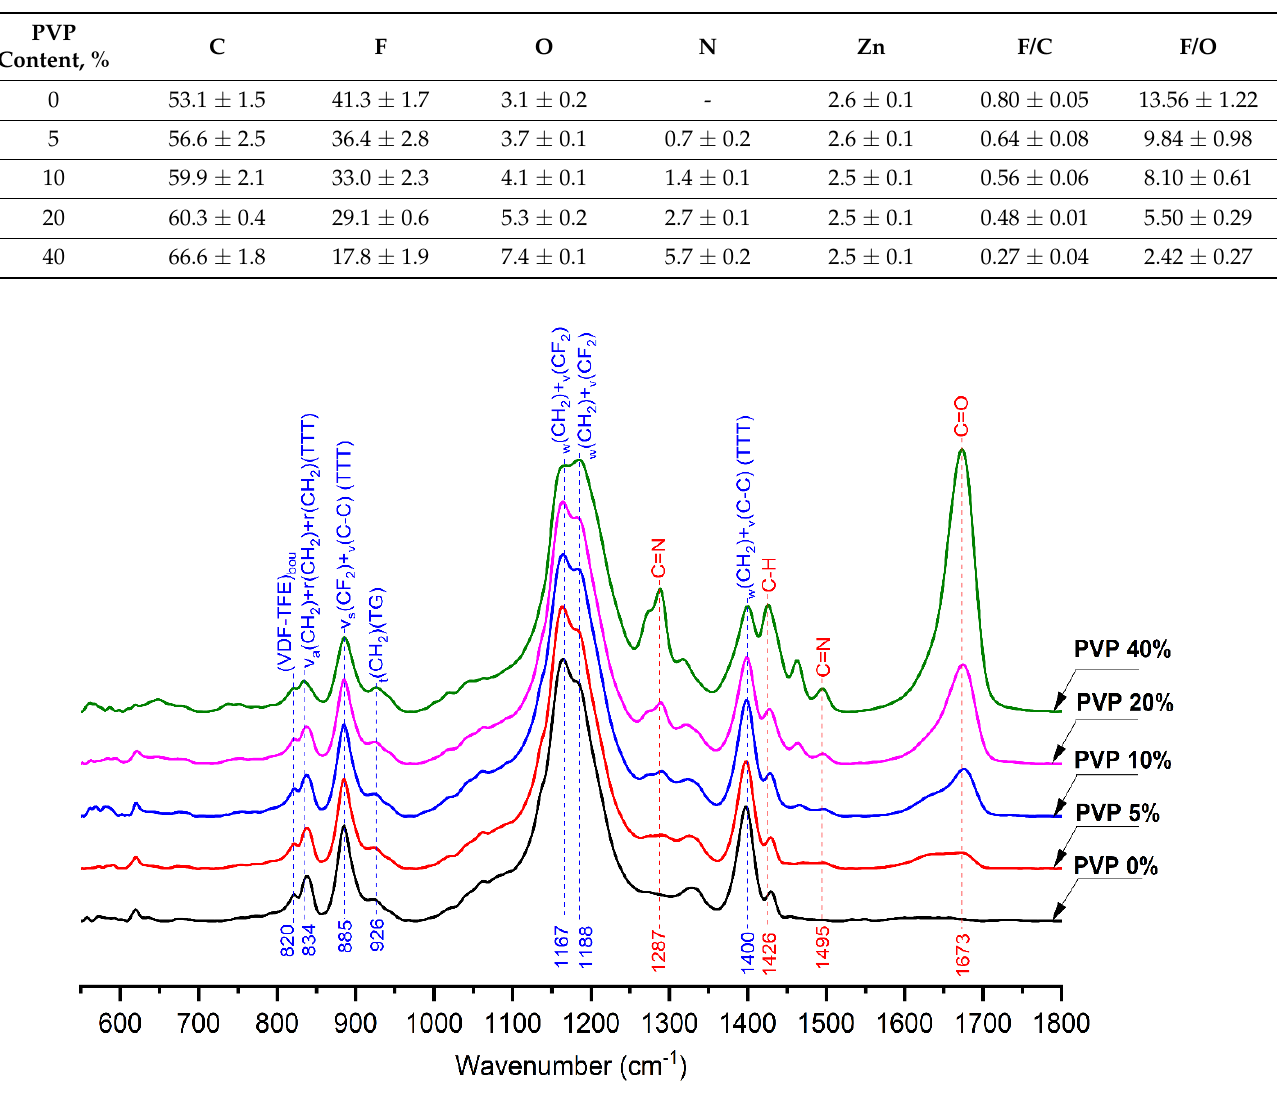
Table 2. Chemical composition of the fabricated membranes, studied by the EDX method, at%.